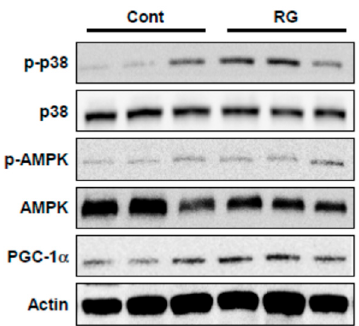
Figure 7. Effects of RG on protein expression in the muscles of mice fed a vehicle or RG. Mice were fed with vehicle or 100 mg/kg RG for 28 days. Muscle tissue (tibialis anterior) lysates were immunoblotted with antibodies against phosphorylated-p38 MAPK (p-p38), phosphorylated AMPK (p-AMPK), total p38, AMPK, PGC-1 α , and actin as a loading control.